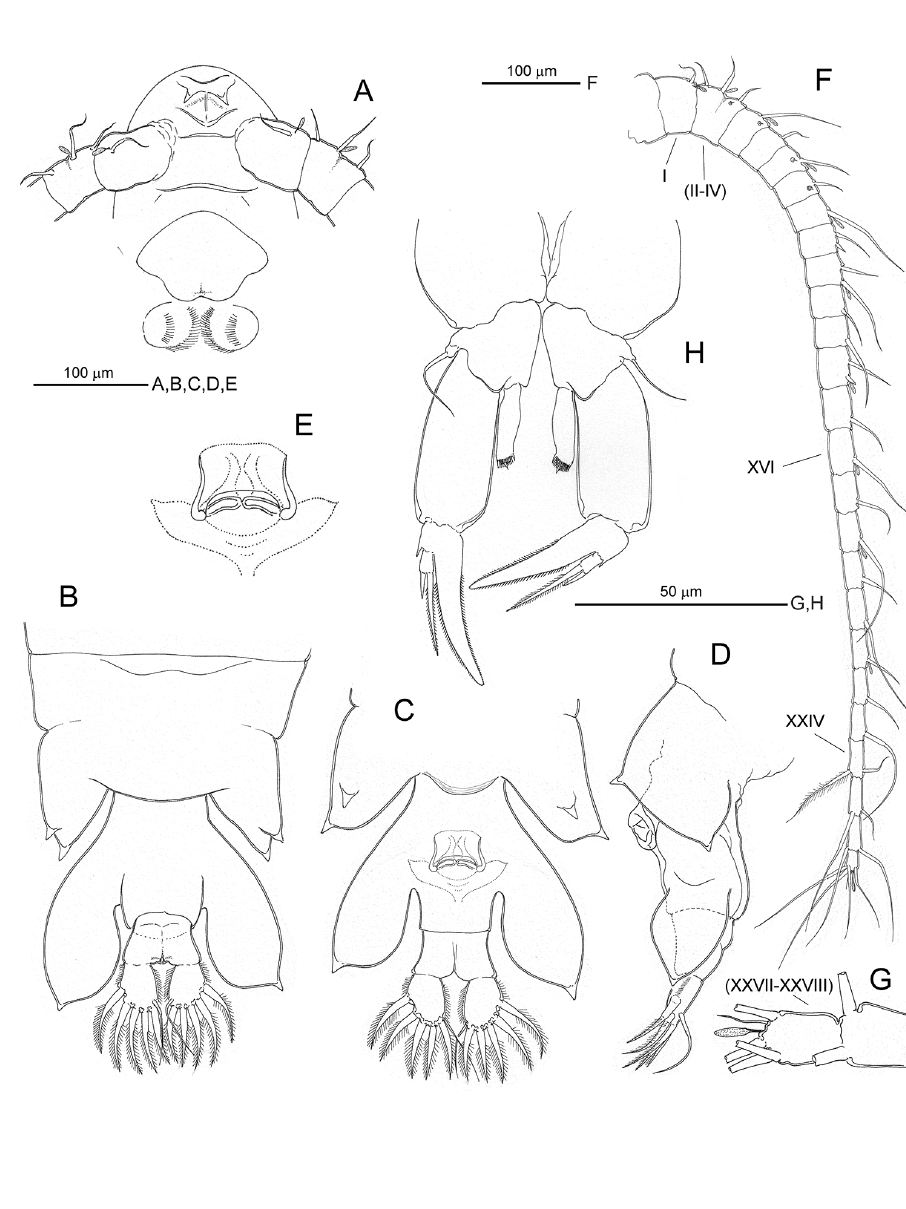
Figure 1. Notodiaptomus cannarensis sp. n., adult female. A anterior portion of prosome showing ros- trum, insertion of antennules, labrum and paragnaths, ventral B last pedigerous somite plus urosome and caudal rami, dorsal C same, ventral D same, left lateral E inset of genital aperture F right antennule, ventral G inset of terminal segments of latter H fifth legs,